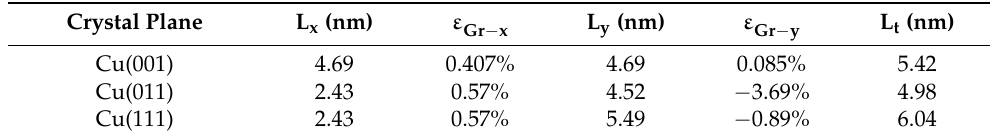
Figure 1. ( a ) Schematic of the NEMD method. ( b ) Temperature distribution of the copper/graphene model. The temperature differences near the hot and cold zones are denoted by ∆ T hot and ∆ T cold , respectively. ( c ) Atomic structures of copper (100), (110), and (111) surfaces. Table 2. The model parameters choosing different crystal planes of Cu and the corresponding mismatch strain of